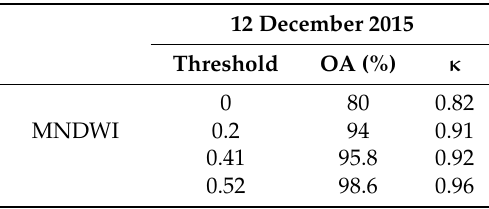
Table 6. Accuracy comparison of the different threshold of the lake area extracted by